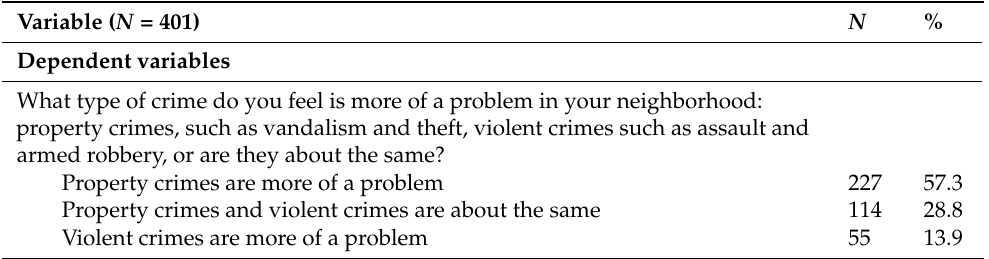
Table 1. Characteristics of Survey